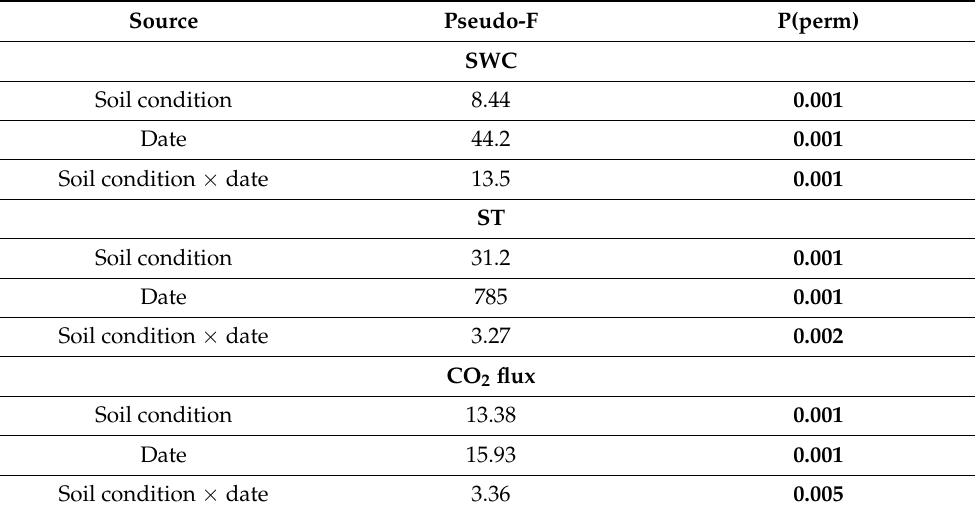
Table 1. Results of the PERMANOVA that was applied to the soil water content, temperature, and CO 2 that were measured at two dates under five soil conditions in the experimental site (Li é tor, Castilla La Mancha,